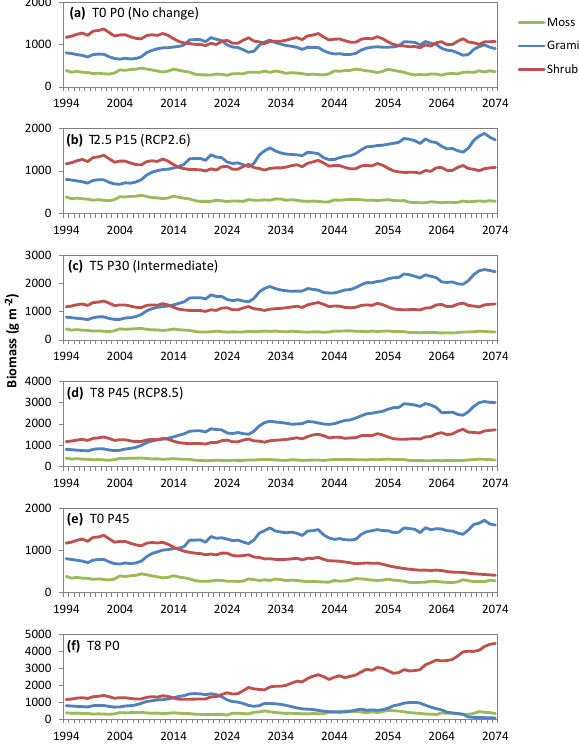
Figure 4. Simulated summer biomass of moss, graminoids and dwarf shrubs between 1994 and 2074 under different temperature ( T , ◦ C increase) and precipitation ( P , % increase) change scenar- ios over the 21st